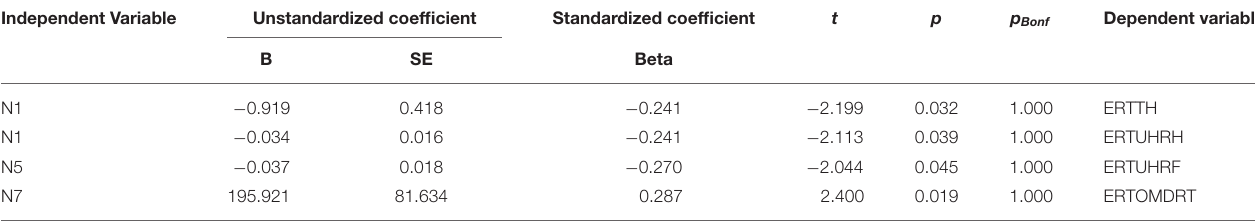
TABLE 3 | Regression analysis predicting the ERT items resulting from the correlation analyses. Independent